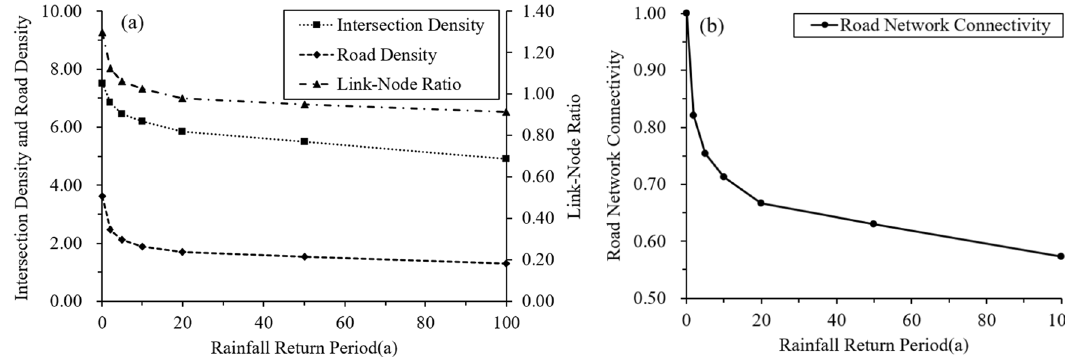
Figure 10. Relationship between road connectivity and rainfall. This graph was generated with OriginPro 2021 (Learning Edition)(https:// www. origi nlab.